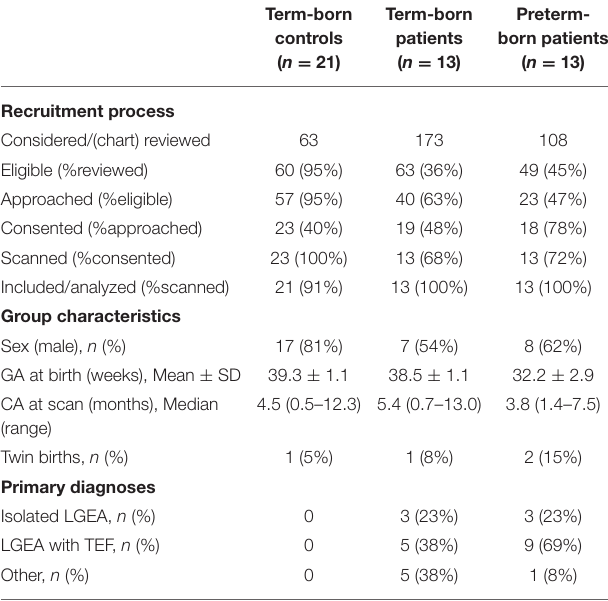
Table summarizes demographic and clinical characteristics for the 3 groups (term-born